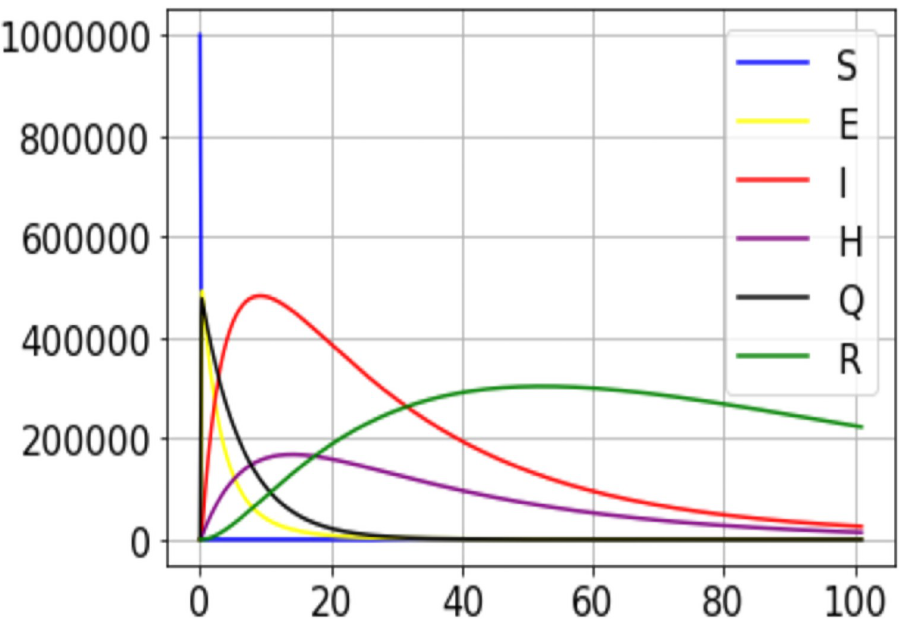
Fig 4. A simulation result for the outbreak using data from the 100 first days data from DRC( � = 3.1).